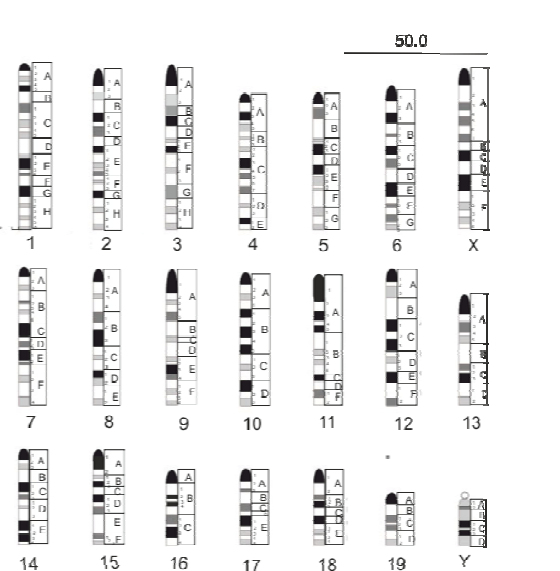
F IGURE 2. Chromosome ideogram of the Iranian house mouse was made according to G-banding T ABLE 2. List of characters used for chromosome